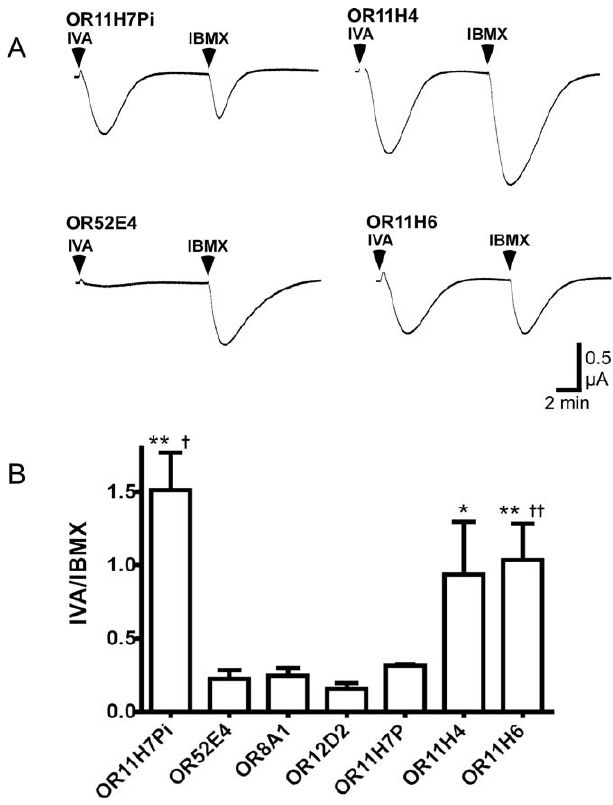
Figure 4. OR Responses to IVA (A) Representative current traces from Xenopus oocytes expressing the OR11H7Pi , OR52E4 , OR11H4 , or OR11H6 receptor (see Materials and Methods) challenged with 15-s applications of 3 mM IVA and 1 mM IBMX. (B) Summary of the 4–12 recordings from oocytes expressing OR11H7Pi , OR52E4 , OR8A1 , OR12D2 , OR11H7P , OR11H4 , or OR11H6 . Responses were normalized to the 1 mM IBMX response in the same oocyte and are presented as mean 6 standard error of the mean. Significant differences from OR52E4 , OR8A1 , and OR12D2 : *, p , 0.05; **, p , 0.01. Significant differences from OR11H7P : (cid:2) , p , 0.05; (cid:2)(cid:2) , p , 0.01.